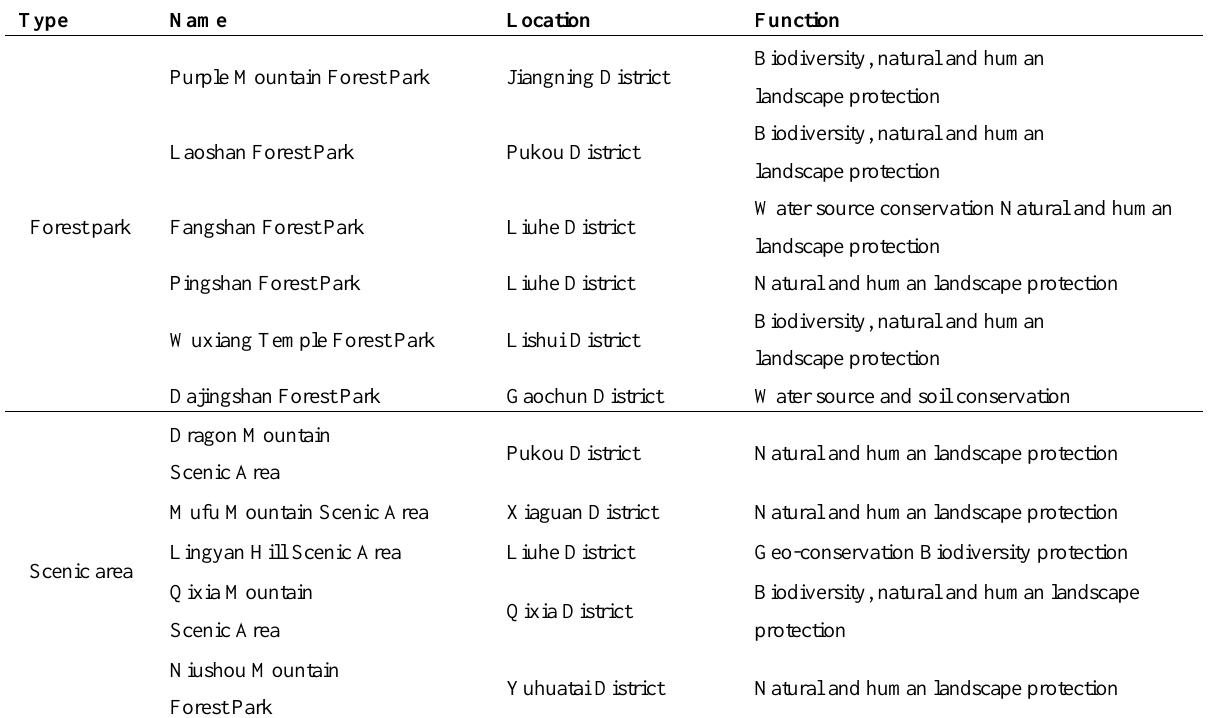
Table 5. Ecological nodes in 2010 of